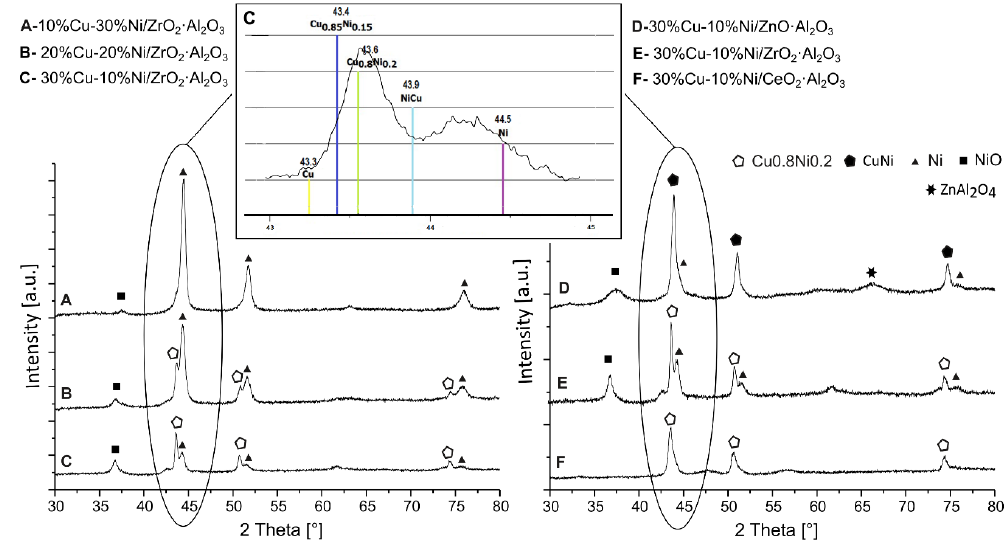
Figure 8. X-ray diffraction curves of various bimetallic catalysts reduced in 5% H 2 - 95% Ar mixture Figure 8. X-ray di ff raction curves of various bimetallic catalysts reduced in 5% H 2 –95% Ar mixture at at 300 °C for 1 h and tested in OSRM process. 300 ◦ C for 1 h and tested in OSRM